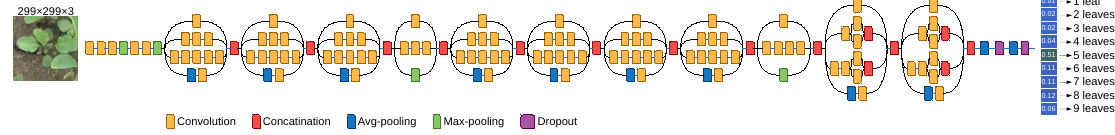
Figure 4. Inception-v3 architecture with modified last